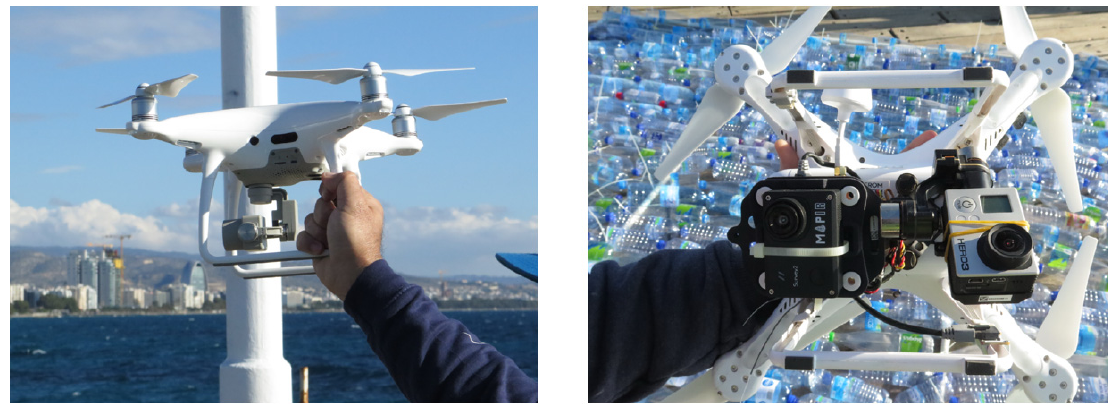
Figure 4. Left : Phantom 4 Pro with RGB integrated 20MP camera. Kyriacos Themistocleous. Right : Phantom 2 with Sony Exmor and modified GoPro camera. Kyriacos Themistocleous.